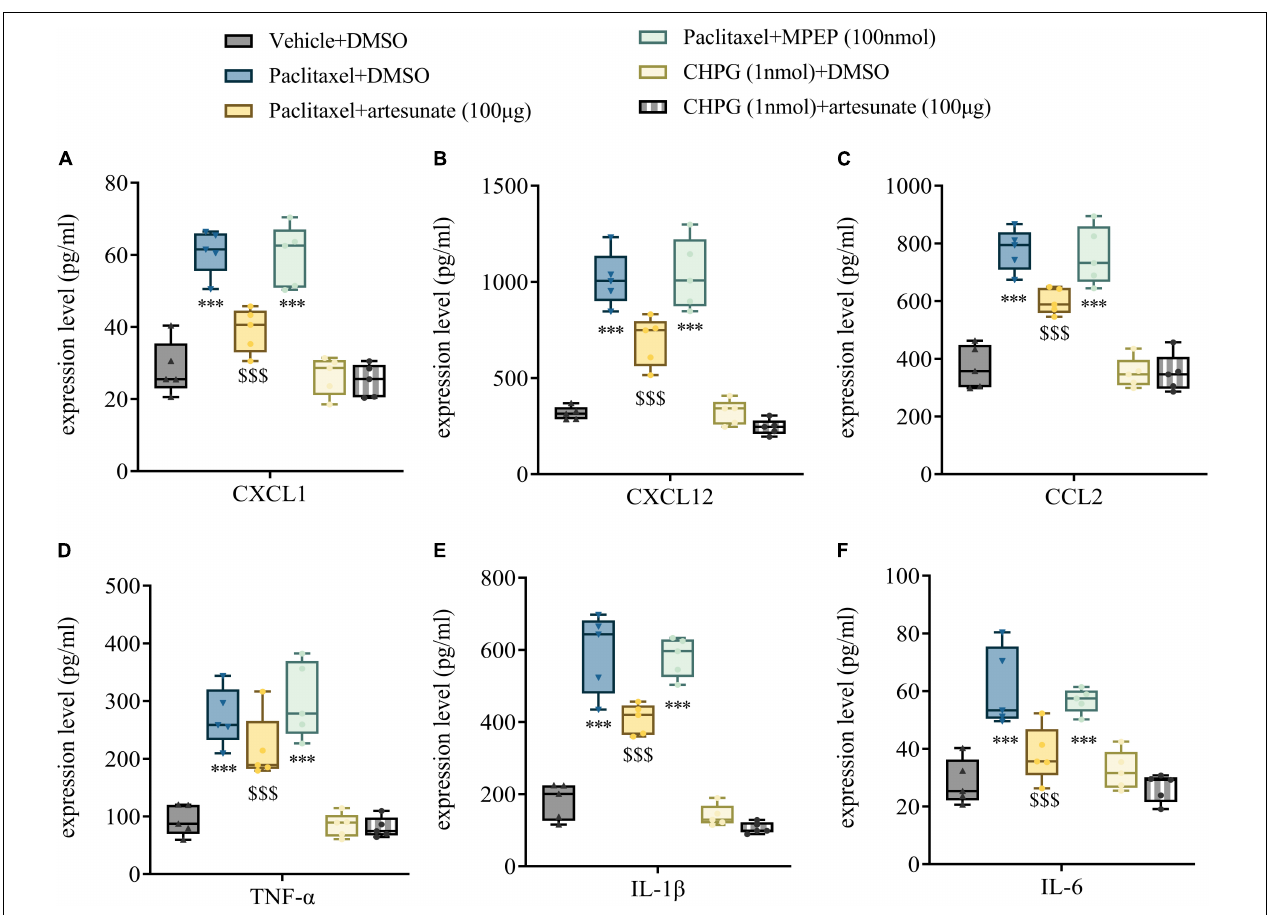
FIGURE 6 | Artesunate reduces DRG neuroinflammation by paclitaxel treatment in mice. Bilateral L3-5 DRGs were obtained from mice 10 days following the initial paclitaxel administration. ELISA detected the DRG levels of CXCL1 (A) , CXCL12 (B) , CCL2 (C) , TNF- α (D) , IL-1 β (E) , and IL-6 (F) in mice. Data are median with interquartile ranges, and individual data points are shown ( n = 5). *** P < 0.001 vs. Vehicle + DMSO group; $$$ P < 0.001 vs. Paclitaxel + DMSO